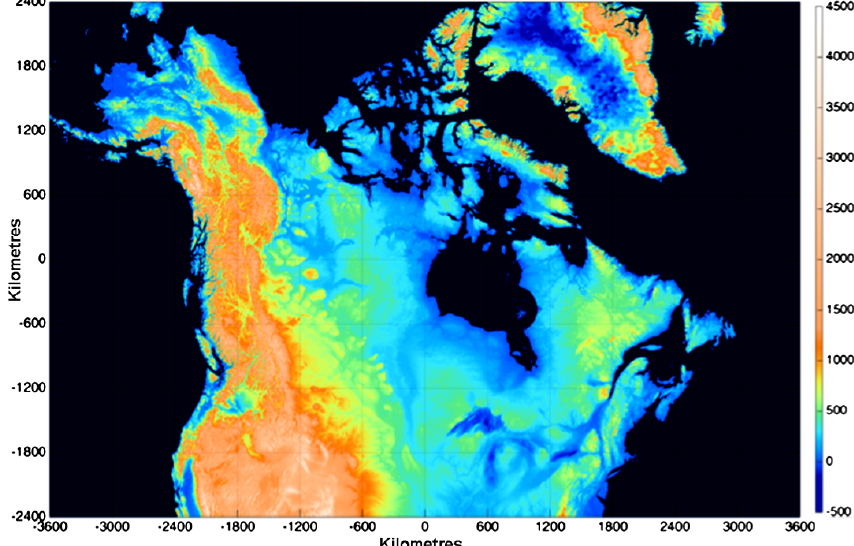
Figure 3. The present-day land–ocean mask (uniform deep blue) and the bedrock topography at 1km